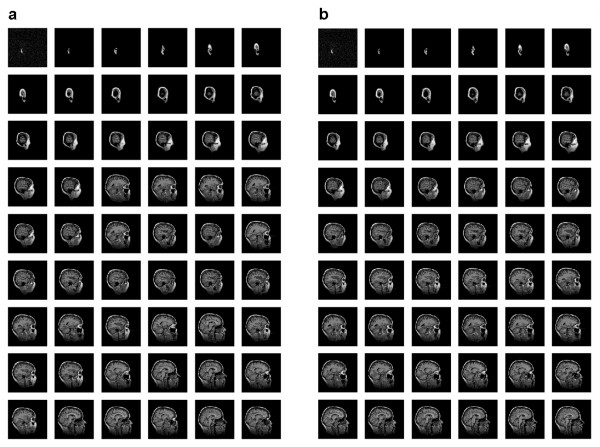
Images ordered by the primary eigenfunction for PCA-correlation and the spectral method from Lafon [3,4]. (a) The ordering is not correctly preserved with PCA-correlation (in this series, moving from left to right and top to bottom). (b) The order is correctly preserved with the spectral method from Lafon [3,4] (in this series, moving from left to right and top to bottom).